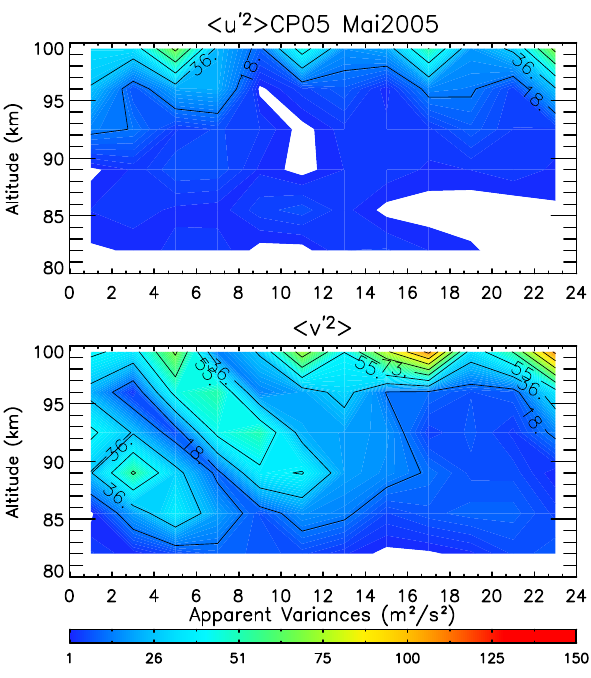
Fig. 20. Zonal (top) and meridional (bottom) apparent wind vari- ances for May 2005 over Cachoeira Paulista (23 ◦ S, 45 ◦ W) using the simulation presented in Sect. 3.